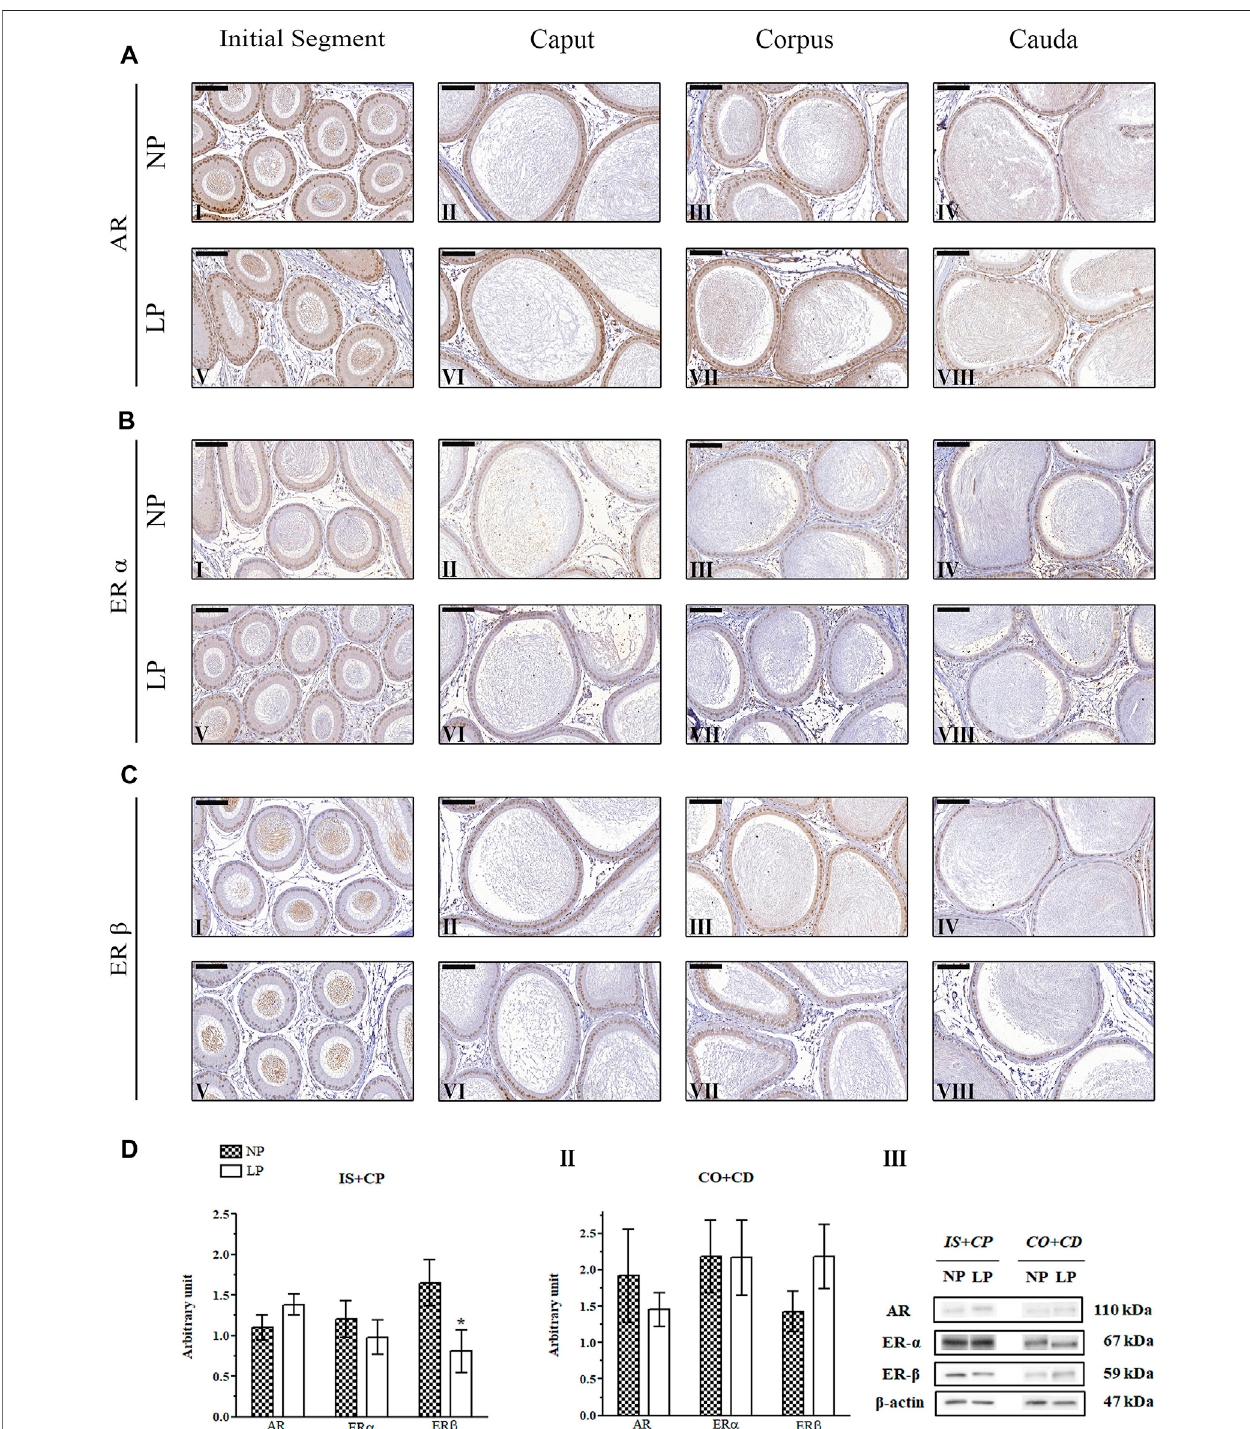
FIGURE 6 | Expression and immunolocalization of AR, ER α and ER β in the epididymides of120-day-old animals. (A) Immunoreactivity for AR in epithelial cells and inmesenchymalcellsintheinitialsegment (IandV) ,caput (IIandVI) ,corpus (IIIandVII) andcauda (IVandVIII) regionsofNPandLPanimals. (B) Immunoreactivityfor ER α in epithelial cells and in mesenchymal cells in the initial segment (I and V) , caput (II and VI) , corpus (III and VII) and cauda (IV and VIII) regions of NP and LP animals. (C) ImmunoreactivityforER β inepithelialcellsandinmesenchymalcellsintheinitialsegment (IandV) ,caput (IIandVI) ,corpus (IIIandVII) andcauda (IV and VIII) regions of NP and LP animals. Bar = 100 µm. (D) Extracts obtained from individual animals were used for densitometric analysis of the levels of the proteins in the initial segment plus caput (I) and corpus plus cauda (II) regions following normalization to the levels of the housekeeping protein β -actin. The representative blots show the protein levels of AR, ER α , ER β and β -actin ( III , right panel). The data are presented as the mean ± S.E.M. * p < 0.05, Mann-Whitney test.